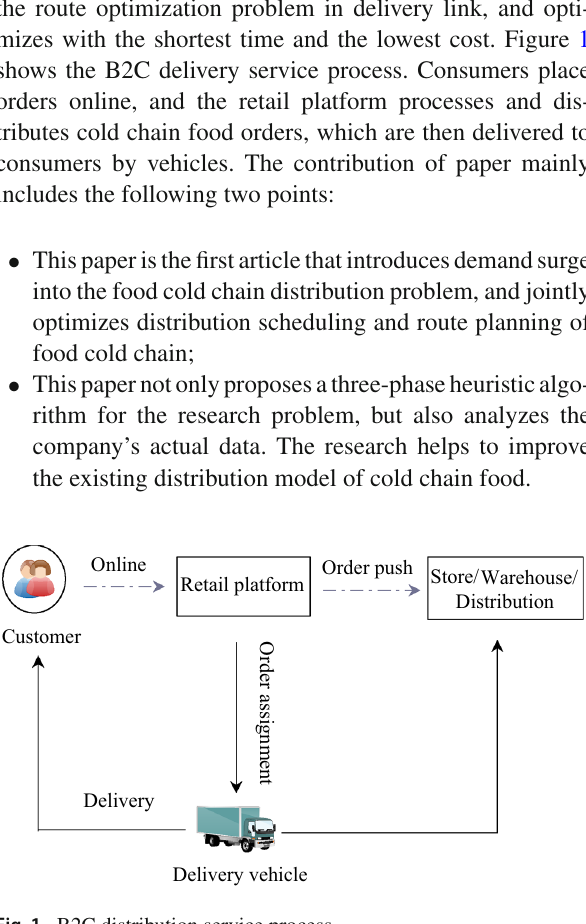
Fig. 1 B2C distribution service